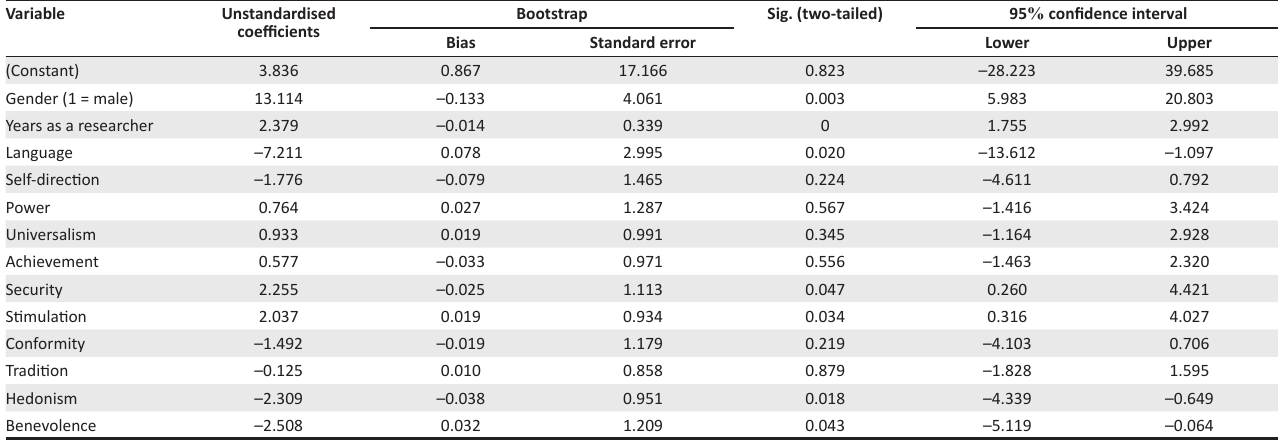
TABLE 5: Bootstrapped standard errors and confidence intervals.